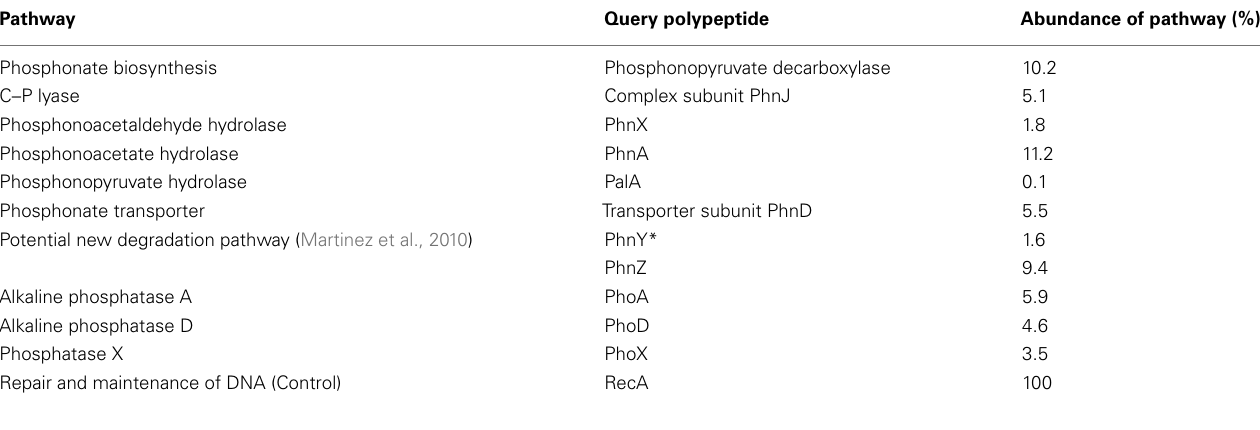
Table 4 |Abundance of phosphonate (and related) metabolic pathways in bacterial genomes sampled by the Global Ocean Survey.